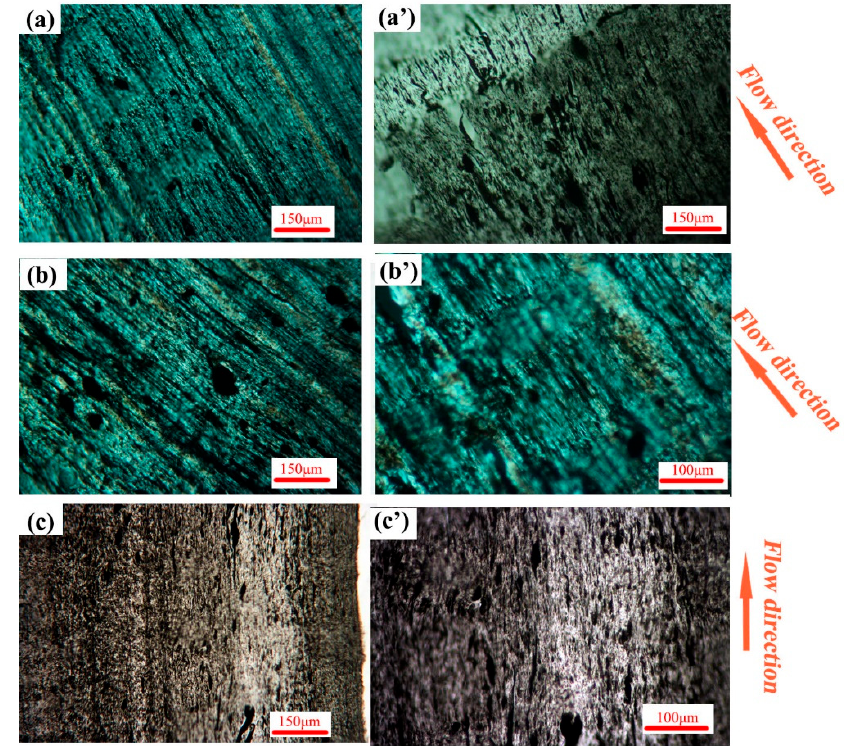
Figure 9. POM images of B2(C) ( a , a ’); B2(M) ( b , b ’); and B2(P) ( c,c ’).